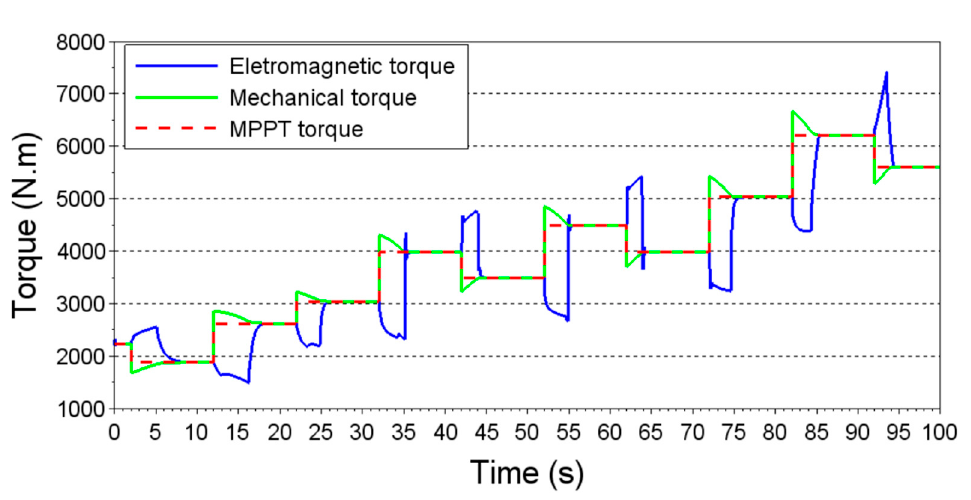
Figure 7. Di ff erence between toques to accelerate the DFIG rotor. Figure 7. Difference between toques to accelerate the DFIG rotor. Figure 7. Difference between toques to accelerate the DFIG rotor.